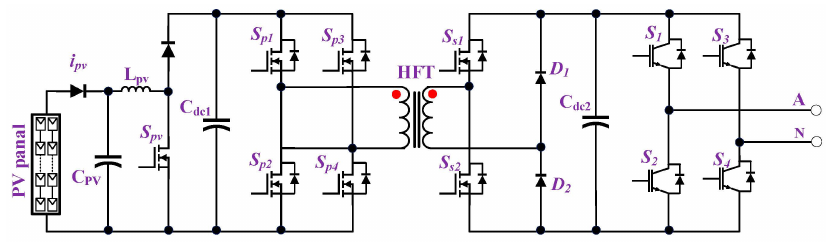
Figure 8. A single submodule of F-DAB converter with CHB cell